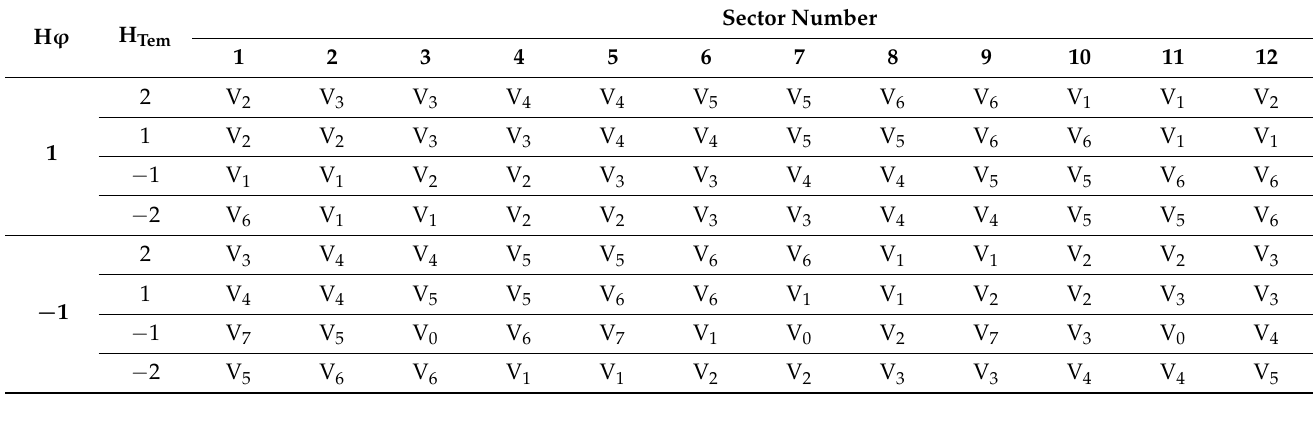
Table 2. Switching table for the proposed 12-sectors DTC.